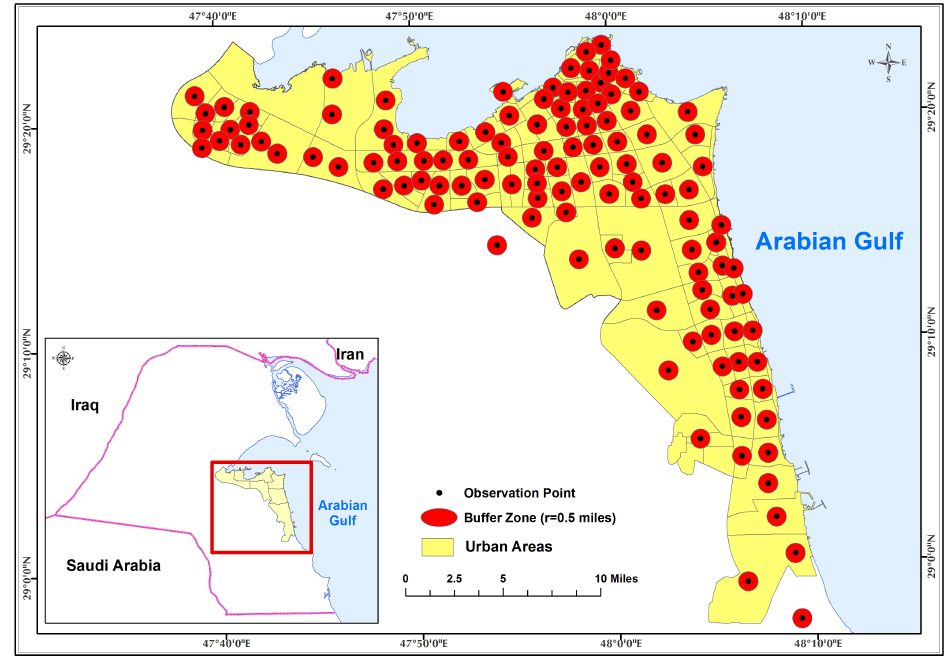
Figure 2. A point map of Kuwaiti urban areas, with a 0.5 mile (0.80 km) buffer zone, for data